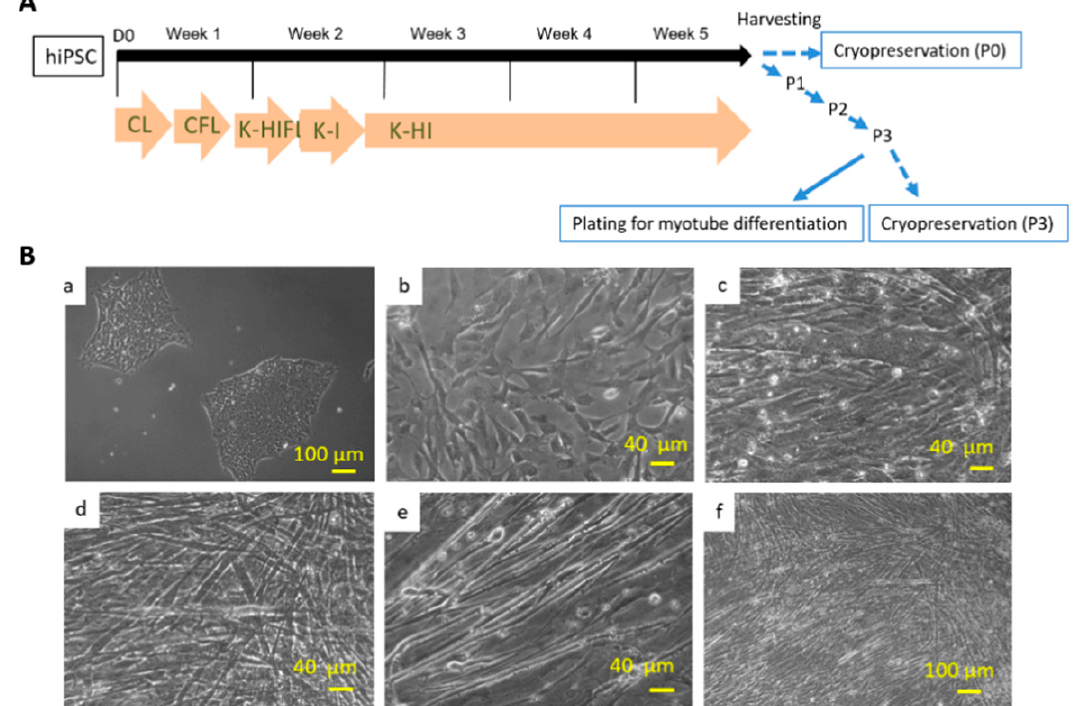
Figure 1. ( A ) Diagram of the myogenic differentiation protocol from hiPSCs. The differentiation protocol from Week 1~5 is basically the same as in Chal’s publication. The culture was then harvested for cryopreservation or 3X series passaging as delineated by the blue arrows, which is the beneficial modification developed in this study. ( B ) Differentiation of myotubes from human iPSCs demonstrated by phase microscopy images. ( a ) iPSCs before myo-lineage differentiation. ( b )